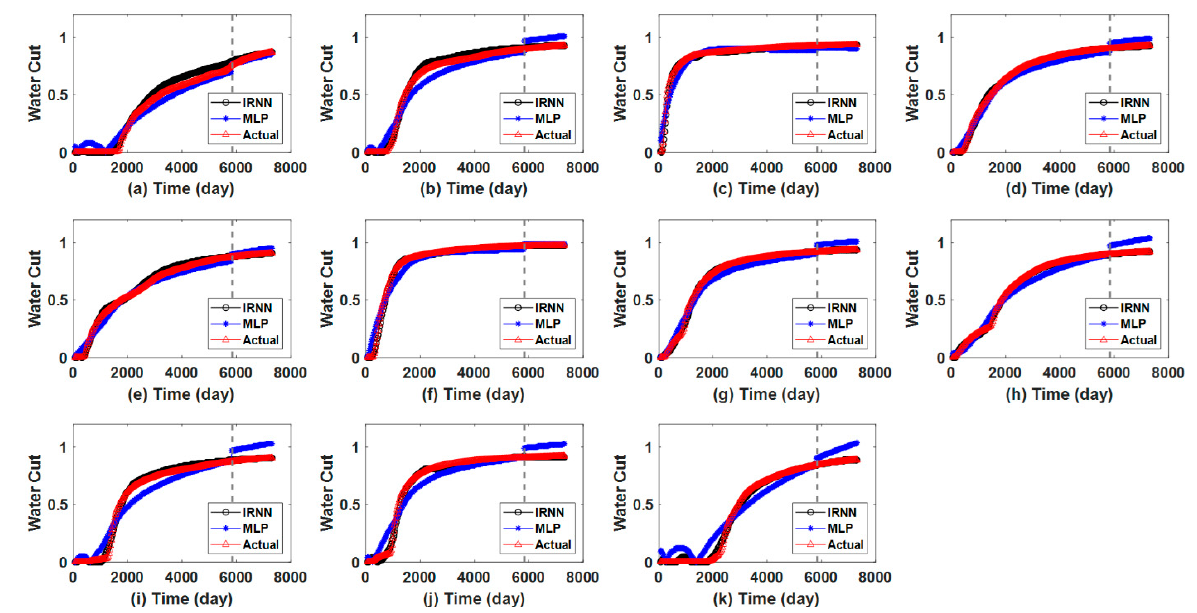
Figure 9. The water cut curves of the Olympus model. The red lines with triangles represent the actual results obtained by the simulator, the black lines with circles represent the results obtained via IRNN, and the blue lines with dots are the results obtained via MLP. The history matching and predicting periods are divided by the grey vertical dashed line. From PRO-1 to PRO-11, the water cut curves of 11 producers are demonstrated in ( a – k ) successively.